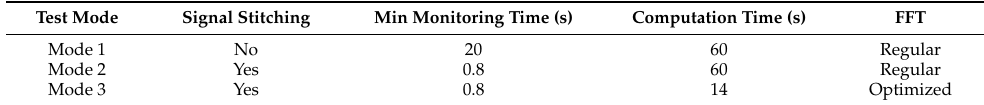
Table 2. Proposed detection method test